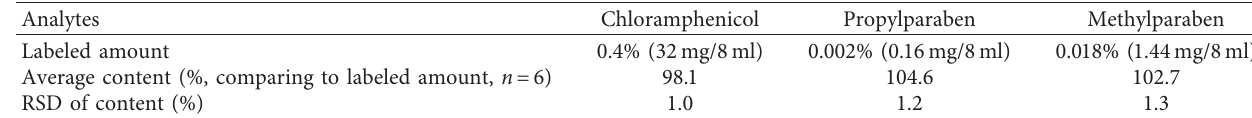
Table 2: Assay results of eye-drops